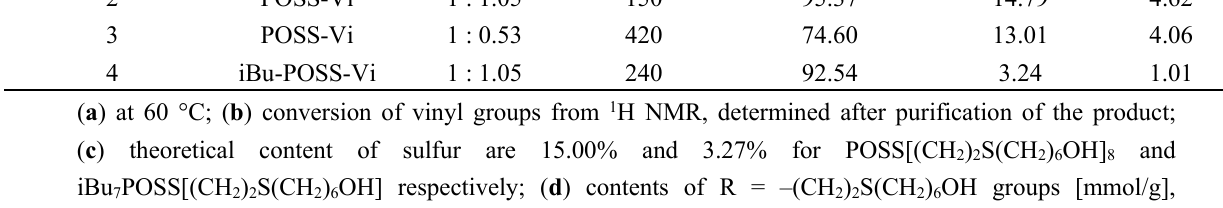
Contents of Sulfur R (d) Content [mmol/1 g] [wt %] (c)